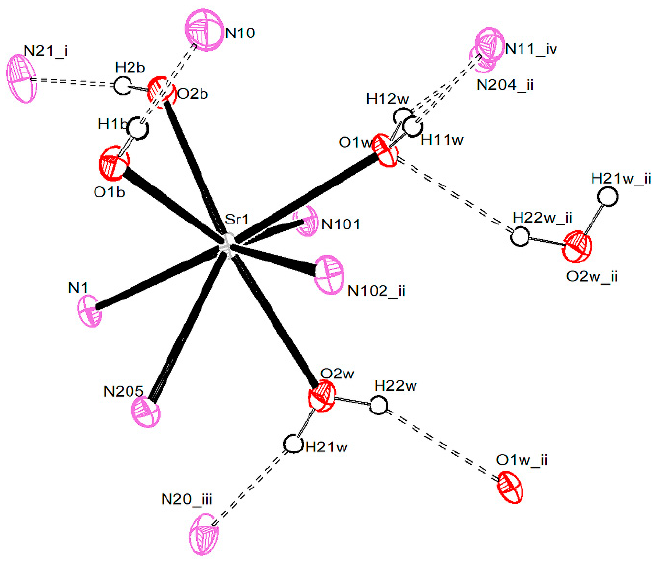
Figure 15. The first and second coordination spheres of Sr 2+ in compound 4 . Symmetry operators: i: x , y , z ; ii: − x , − y , 1 − z ; iii: 1 − x , − y , 1 − z ; iv: − x , 1 − y , 1 − z .